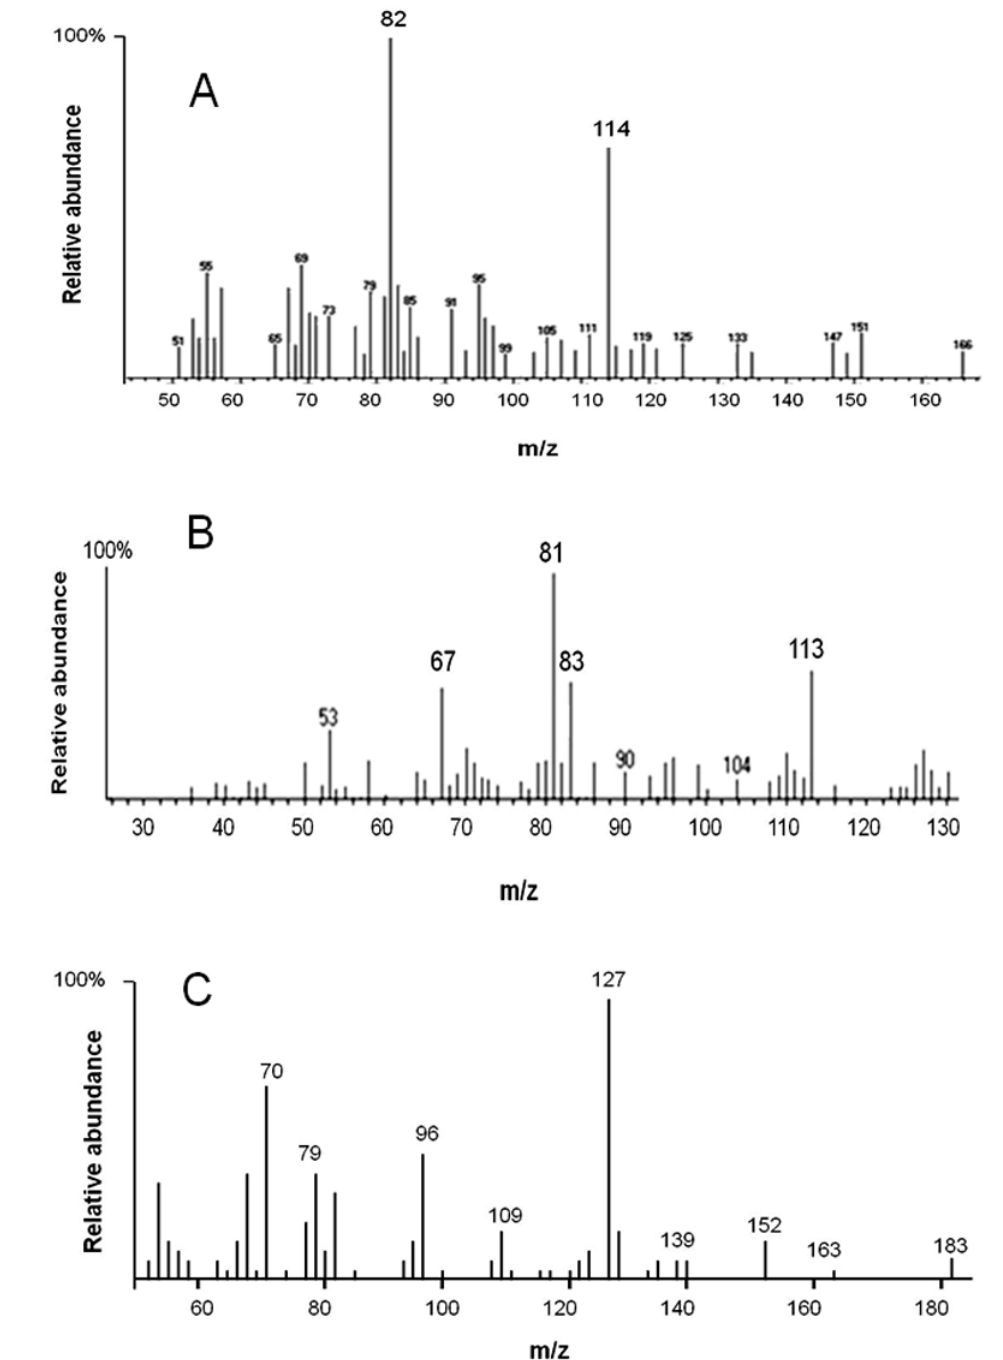
Figure 3. Electron-impact (EI) mass spectra of cantharidin-related compounds, detected in Hycleus scabiosae (Meloidae). ( A ) Palasonin with base peaks at m/z 82 and 114; ( B ) palasoninimide with base peaks at m/z 81, 113, 67, 83 and ( C ) cantharidinimide with base peaks at m/z 127, 70, 96 according to an Agilent 5973 N mass